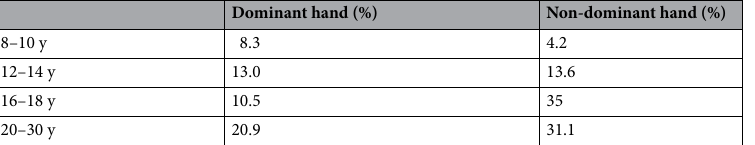
Table 2. Percentage of individuals displaying peak corticomuscular coherence values exceeding the corrected upper confidence limit (α = 0.0033) in the beta-band (15–30 Hz) by group and